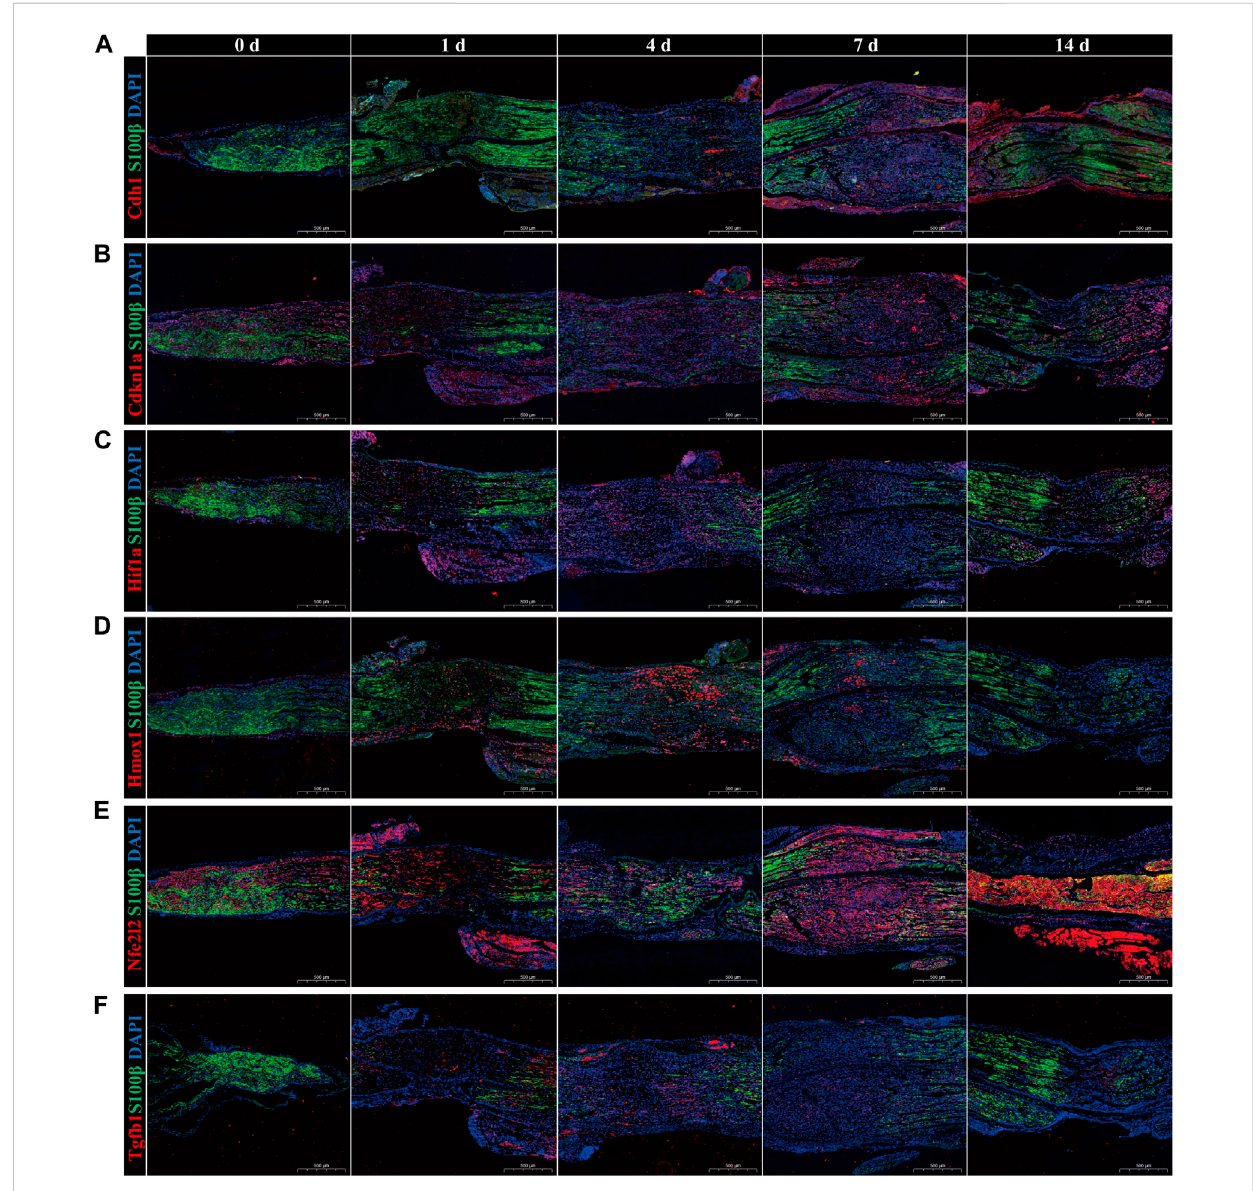
FIGURE 7 Immuno fl uorescence validation of temporal alterations in hub genes expression. The expression of hub genes (A) Cdh1, (B) Cdkn1a, (C) Hif1a, (D) Hmox1, (E) Nfe2l2, and (F) Tgfb1 in sciatic nerve in uncrushed (0 days) group, 1-day, 4-day, 7-day, and 14-day after crush injury. The hub gene was fl uorescent in red, the Schwann cell marker S100 β was fl uorescent in green, and DAPI was fl uorescent in blue. Scale bar = 500 μ m. p -value <